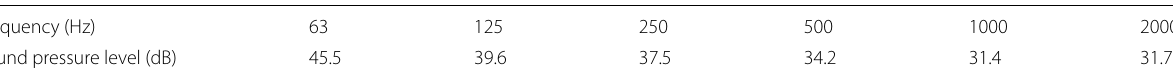
Table 2 Ambient noise in the field test.